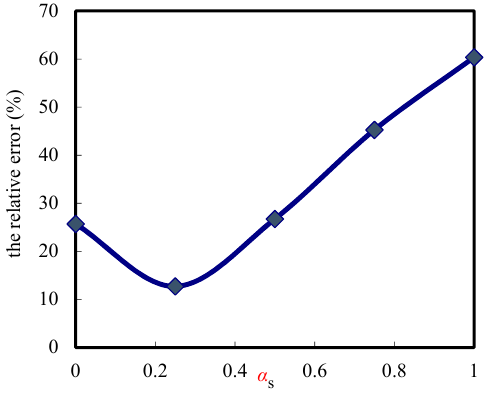
Figure 9. The two-phase permeability average relative errors of core 24 # .